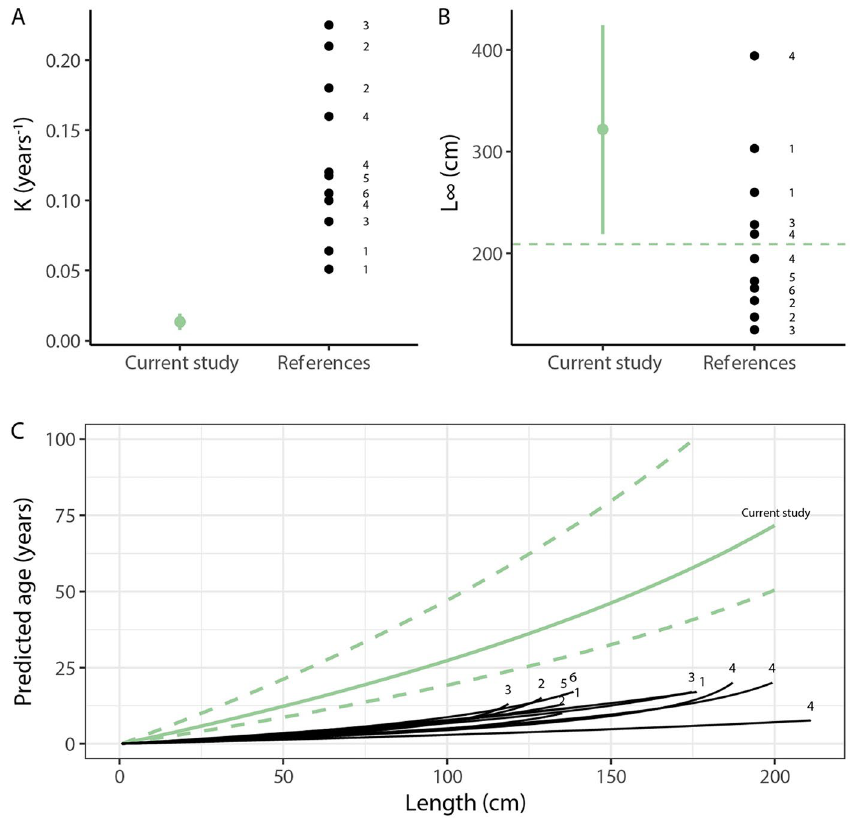
Figure 3. Estimated VBGC parameters K ( A ), L∞ ( B ) and predicted age at length ( C ) for the current study (green) compared to other populations from the core distribution area (black lines and dots; citation for each parameter estimate and growth trajectory: 1 24 , 2 23 , 3 13 , 4 28 in Ref. 13 , 5 53 , 6 25 ). Growth curves for the references were drawn based on values of K and L∞ with the equation Age = loge ((Length − L∞)/(L0 − L∞))/ − K, with L0 set to size at hatching: 0.7 cm 51 . Estimates of K and L∞ are presented along with 95% confidence intervals (green vertical bars). Uncertainty around predicted age (dashed lines) display the 95% confidence interval for K. The dashed horizontal line in ( B ) denote maximum observed length in current study: 209 cm.